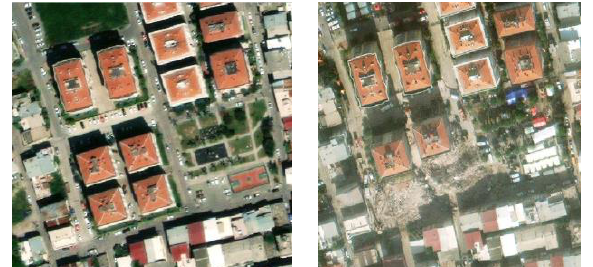
Figure 3. A sample from the optical image (left: pre-EQ, right: